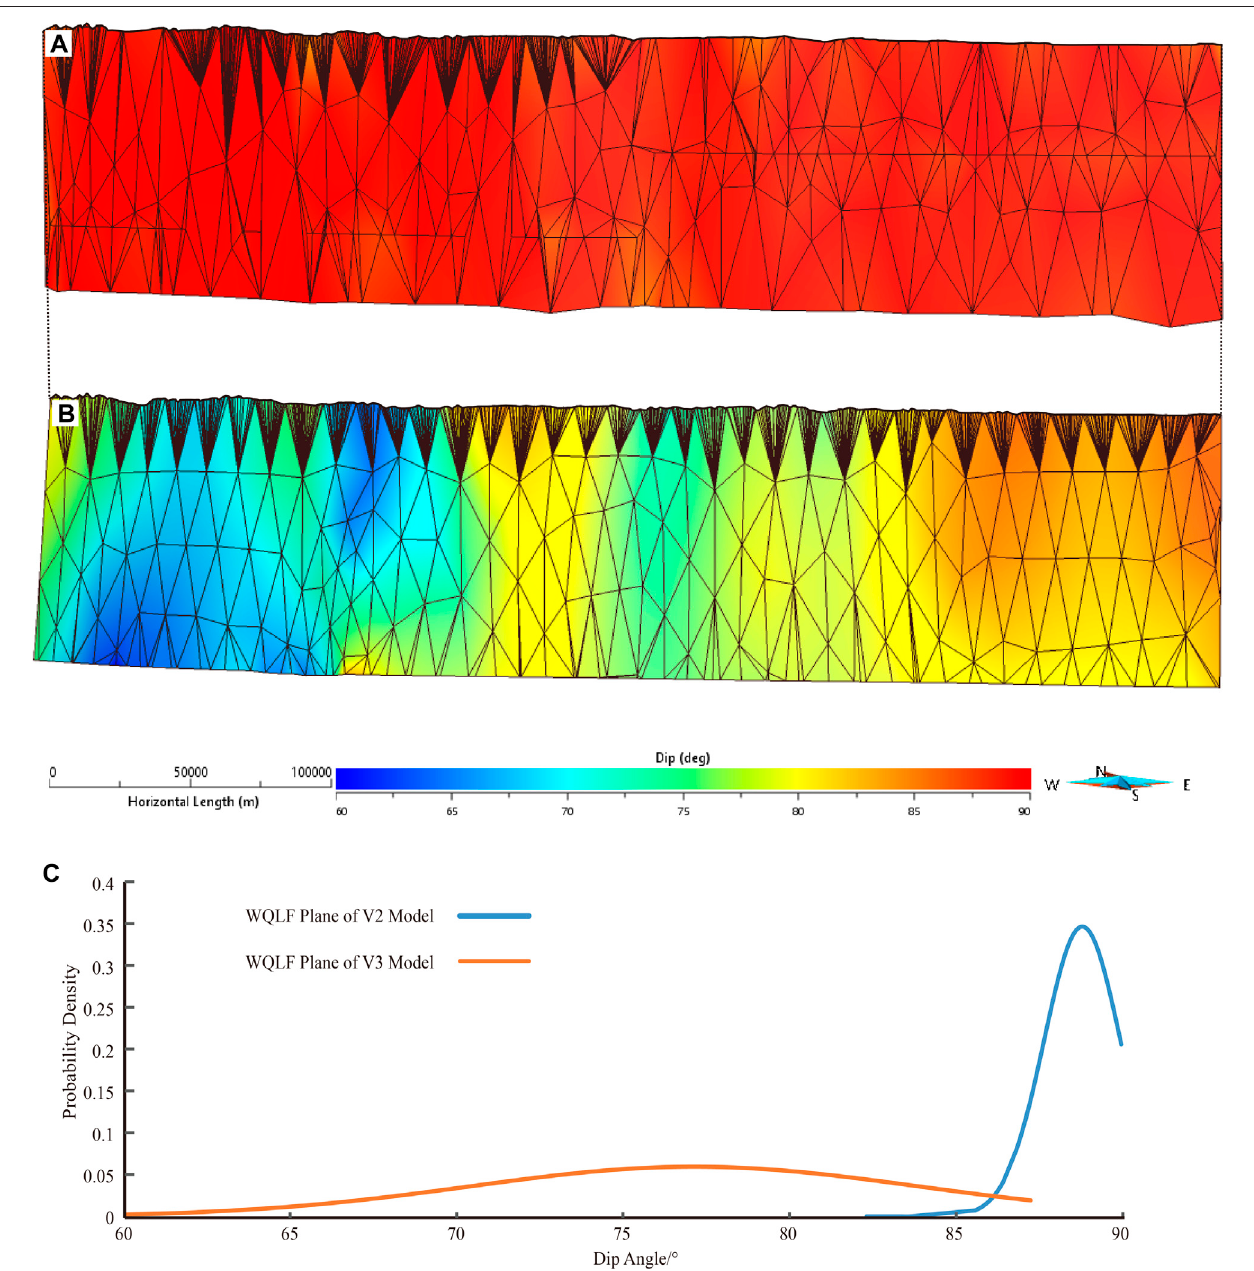
FIGURE 9 | (A) Dip angles of the West Qinling fault planes in the V2 model; (B) Dip angles of the West Qinling fault planes in the V3 model; (C) Normal distribution statisticsofdip angles oftheWest Qinlingfaultplanesin theV2model and V3 model. Thetop ofthe fault planes isoutlined withblacklines, theoriginaltriangular meshis shown, and the colors of the fault planes represent the change of dip angles in (A,B)